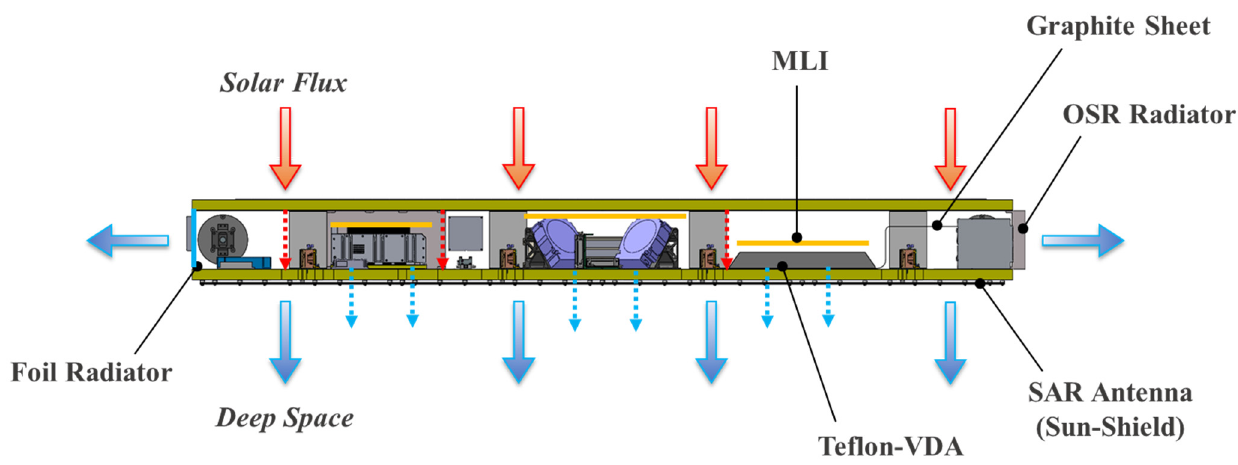
Figure 9. Thermal control design concept for the S-STEP system.